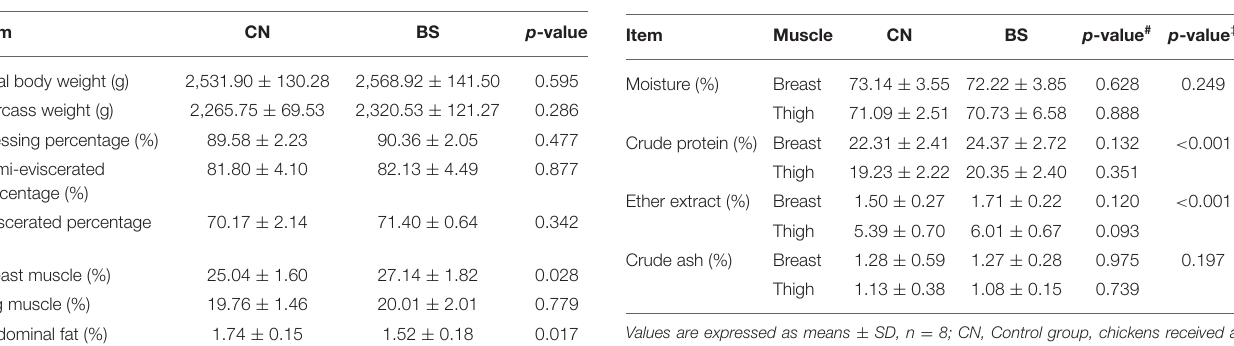
TABLE 4 | Effects of Bacillus subtilis supplementation on conventional chemical composition of broiler